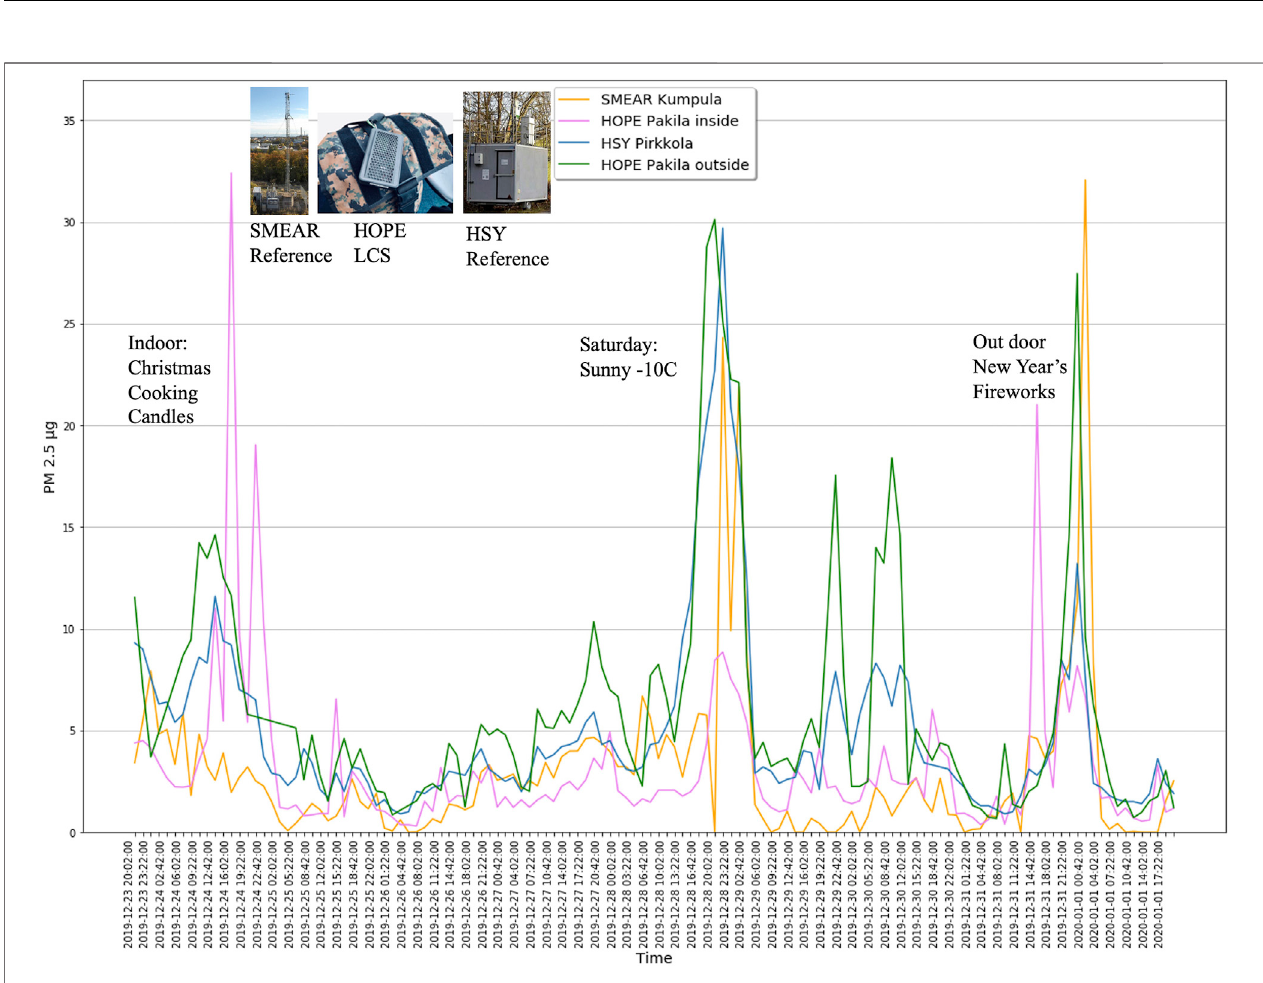
FIGURE 5 | Hourly PM 2.5 concentrations from HOPE sensors outdoors (green) and LCS indoors (pink) in comparison with that measured at reference stations in Pirkkola (blue) and SMEAR III (yellow) in Pakila Christmas week (2019).